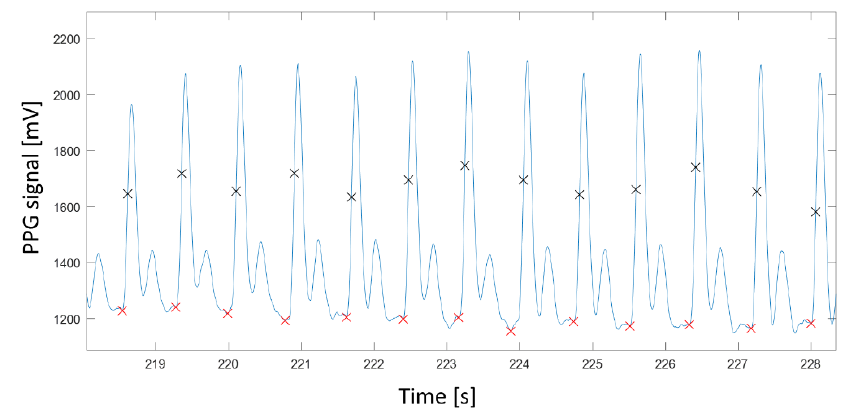
Figure 3. Example showing 13 beats of PPG recording together with the detected foot (red crosses) and max slope (black crosses) fiducial points. The foot points were located based on identifying negative-to-positive zero-crossing points of the first derivative of the signal, and the subsequent peak of the derivative was used to locate the max slope fiducial point.